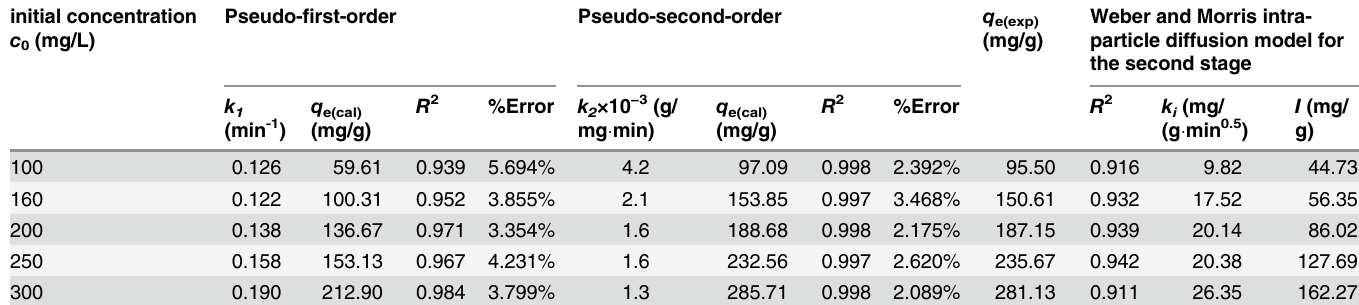
Table 1. Kinetics parameters of pseudo-first-order, pseudo-second-order and Weber and Morris intra-particle diffusion of reserpine adsorption onto the SACEF. Pseudo- fi rst-order Pseudo-second-order q e(exp) initial concentration c 0 (mg/L)